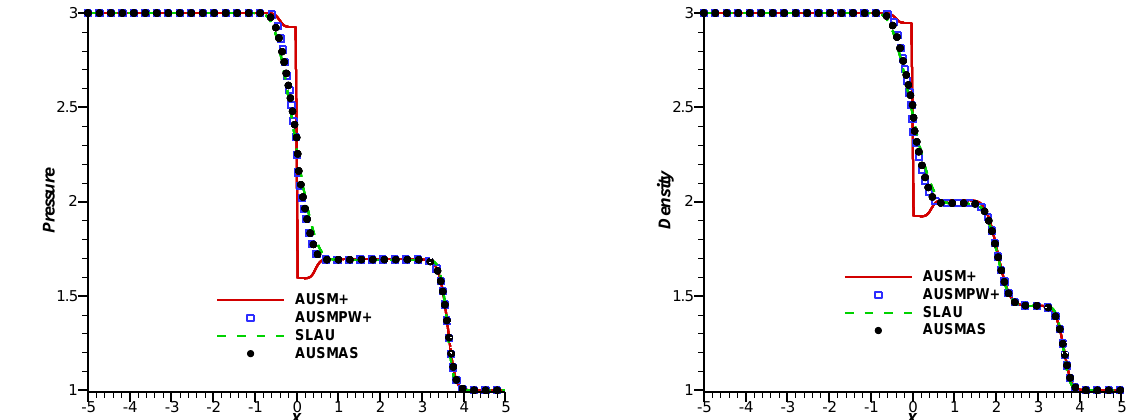
Figure 9. Pressure and density distributions of the Sod shock tube II test ( t = 1.5 s).